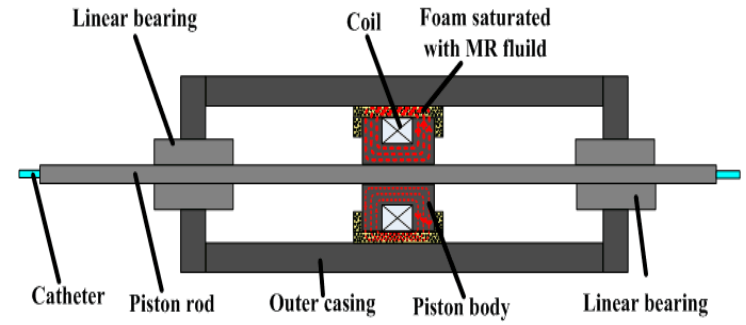
Figure 21. Magnetorheological (MR) fluid damper assembly.